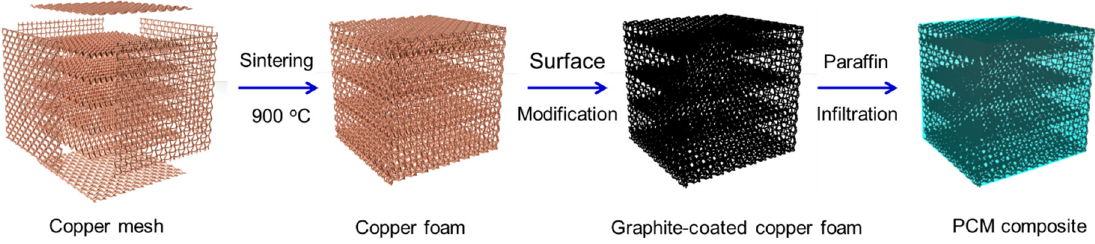
Figure 1. Fabrication process of the copper foam-based composite PCM.